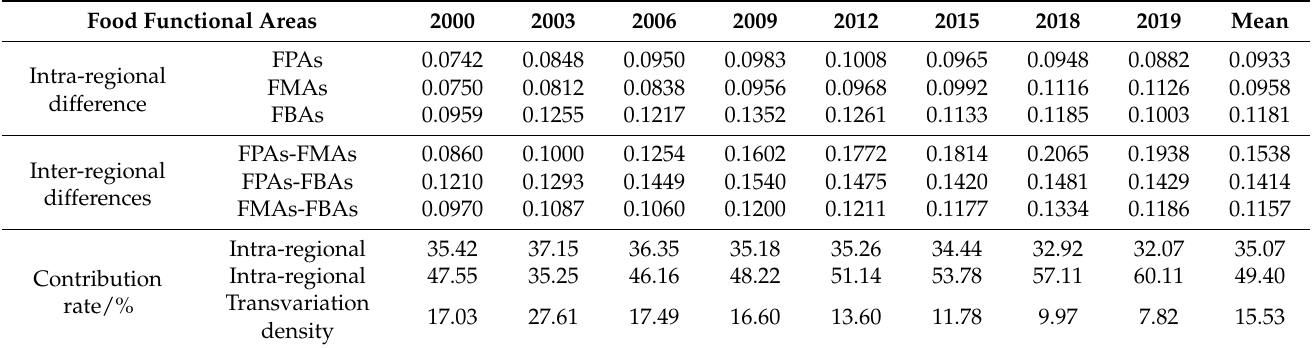
Table 3. Regional differences and their sources of CDUFS in different functional